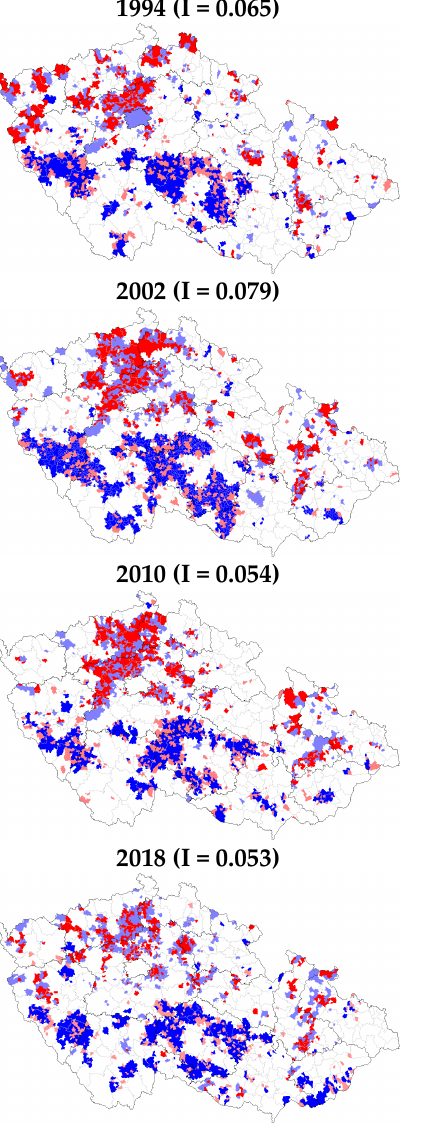
Figure 2. Univariate local indicators of spatial association (LISA) cluster maps for women’s descriptive representation in Czech local elections for the period from 1994 to 2018. Source: Czech Statistical Office; own calculation. Note: All LISA cluster maps are calculated for distance-based spatial weights with a fixed Euclidean distance and a threshold distance of 10 km.